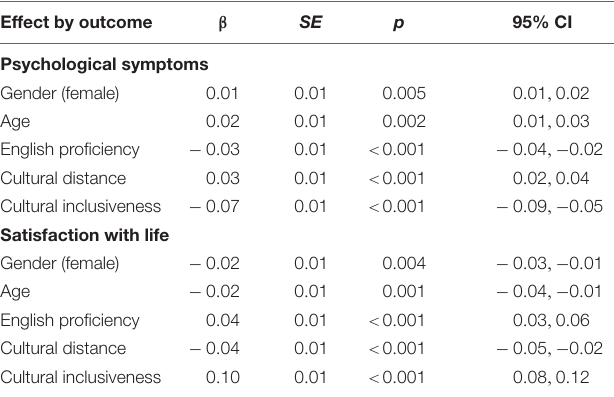
TABLE 2 | Standardized indirect effects on psychological symptoms and life satisfaction through host national connectedness. Effect by